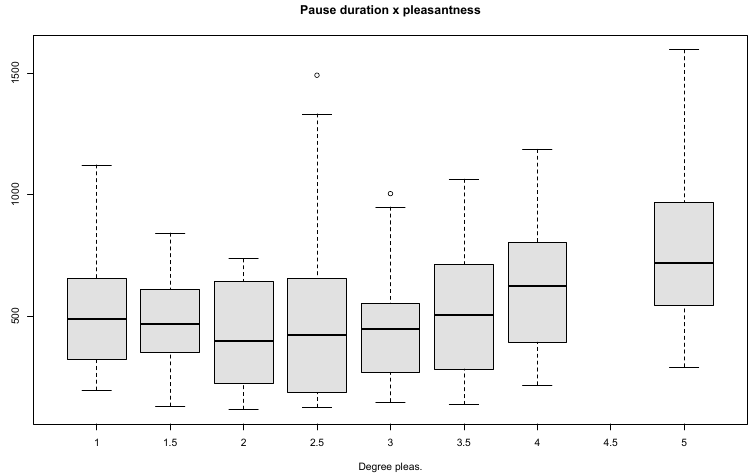
Figure 10. Pleasantness degree attributed by Brazilian listeners to the BP declamations, according to IPI (s). The circles outside the boxes are outliers.